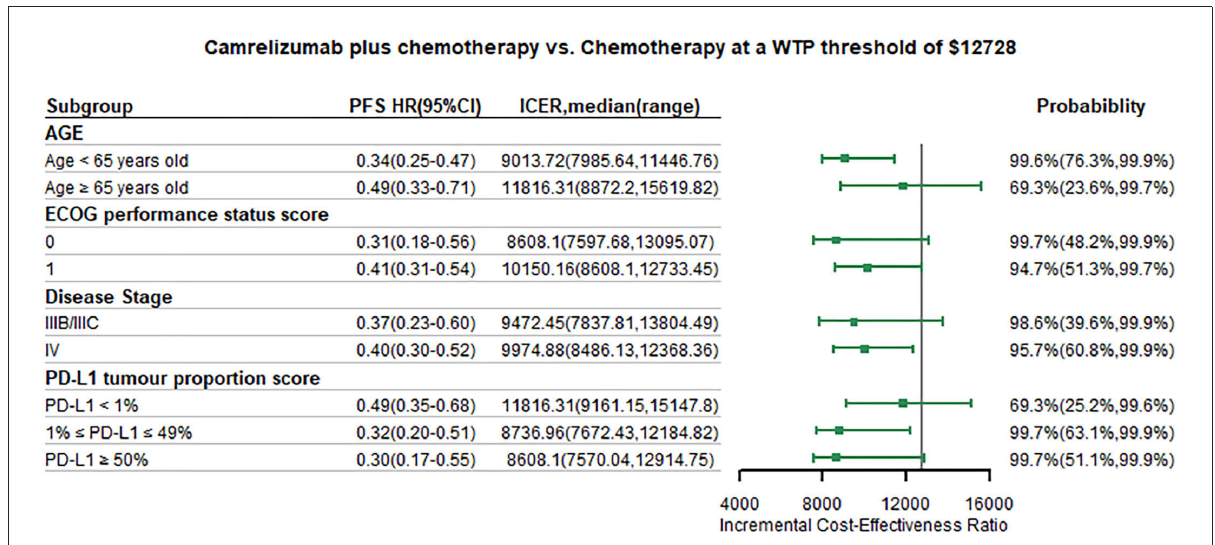
FIGURE5 Subgroup analysis results of incremental cost-effectiveness ratio (ICER) and probabilities of cost-effectiveness obtained by varying the hazard ratios (HRs) for progression-free survival. WTP, willingness-to-pay; PFS, progression-free survival; HR, hazard ratio; CI, confidence interval; ICER, Incremental cost-effectiveness ratio.